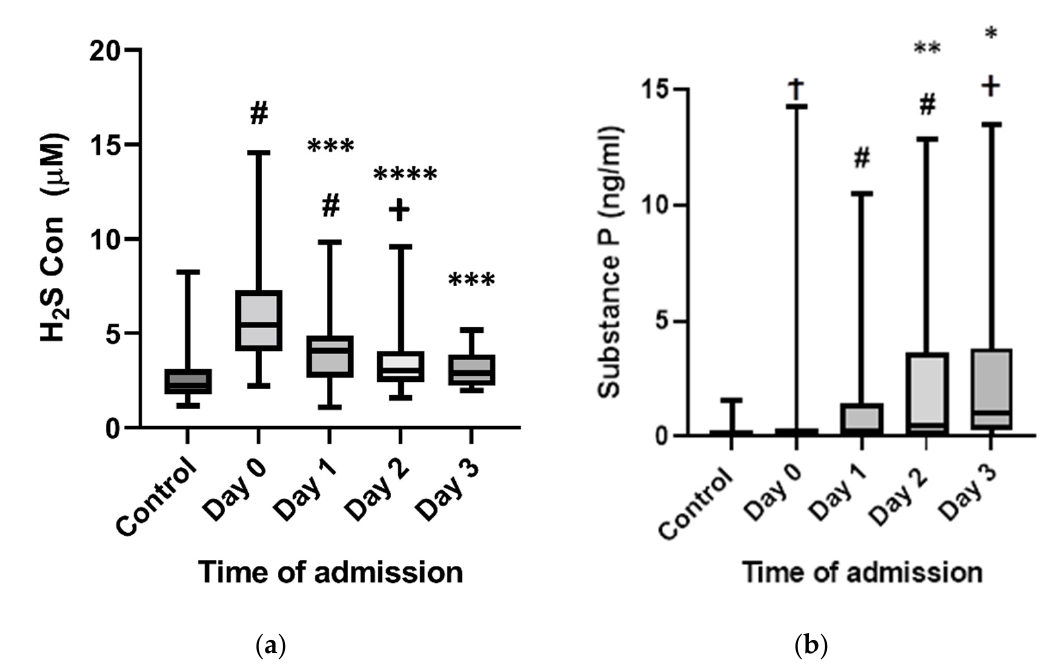
Figure 1. Plasma levels of H 2 S and SP in E. coli - and K. pneumoniae -infected patients. Plasma samples were collected from patients at different time intervals (days 0, 1, 2, day 3). Controls were healthy age- and sex-matched subjects. Plasma H 2 S ( a ) and SP ( b ) concentrations on days 0, 1, 2, and 3 from patients were compared with each other and non-septic control subjects. Results are expressed as the median with the interquartile range (box plot) with the maximum and minimum value (whiskers plot). Two-tailed paired Mann–Whitney tests were performed. # p < 0.0001 vs. control; + p < 0.01 vs. control; † p < 0.05 vs. control; **** p < 0.0001 vs. day 0; *** p < 0.001 vs. day 0; ** p < 0.01 vs. day 0; * p < 0.05 vs. day 0.